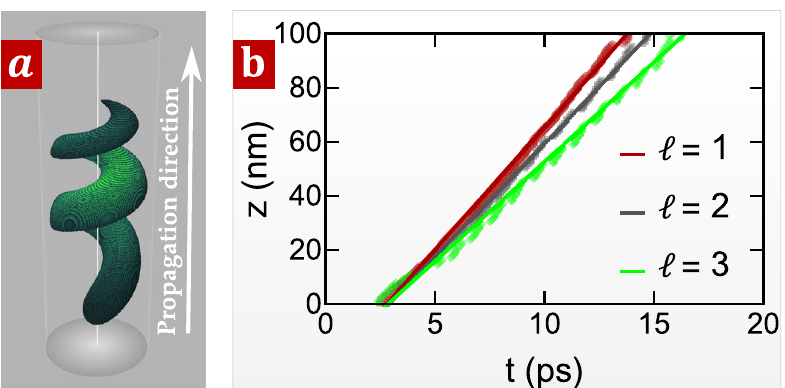
Fig. 5 Propagation of a twisted magnon wave pulse in an AFM waveguide. a A snapshot of the twisted AFM magnonic pulse with ℓ = 1 taken 10 ps after being triggered with the magnetic fi eld of a THz pulse focused on one end of the waveguide. n x component of the staggered fi eld is shown. b Speed comparison for few-cycle twisted magnonic wave packets carrying different OAM.